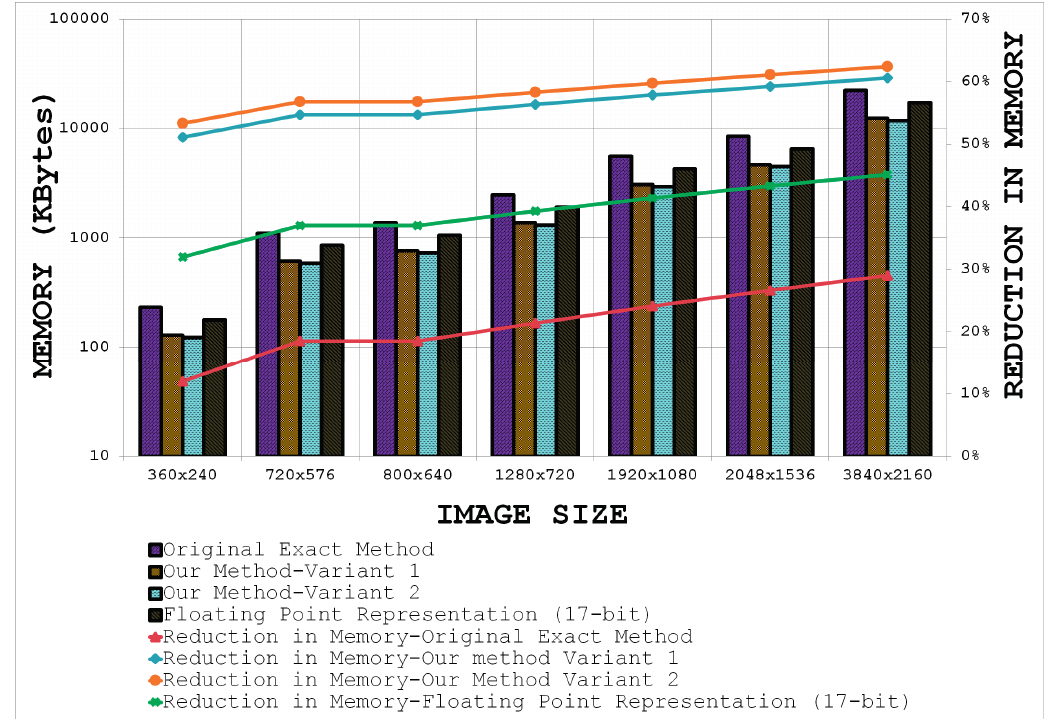
Figure 15. Comparative results for the original exact method [30] and the two variants of the proposed